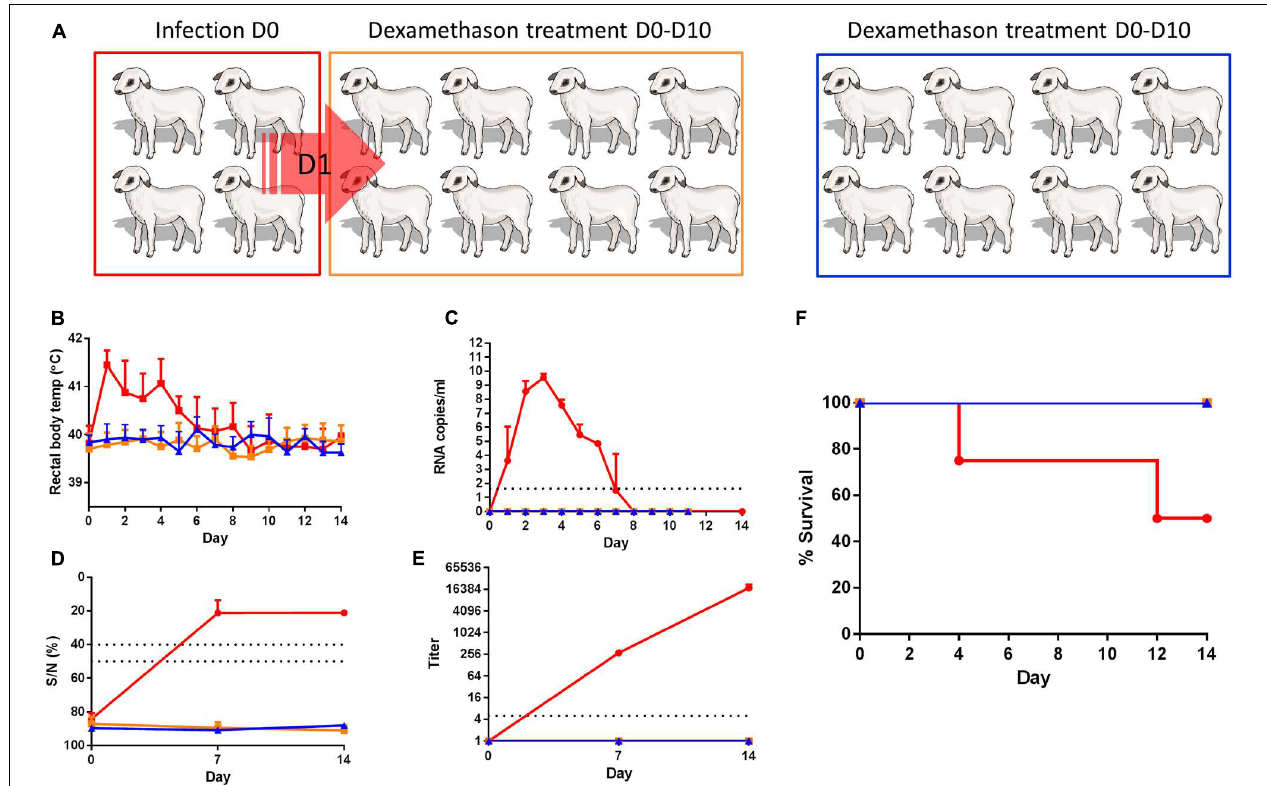
FIGURE 1 | Dexamethasone-treated lambs do not show any evidence of infection upon contact with RVFV viremic lambs. (A) Cartoon representing the experimental design. Four lambs (red) were inoculated with RVFV via intravenous route and co-housed with eight dexamethasone-treated lambs (orange) the next day until the end of the experiment. Another group of 8 lambs functioned as a control group (blue). Rectal temperatures (B) , viremia (C) , antibody responses by ELISA (D) , and virus neutralization test (VNT) (E) and % survival (F) are depicted. Error bars represent averages with